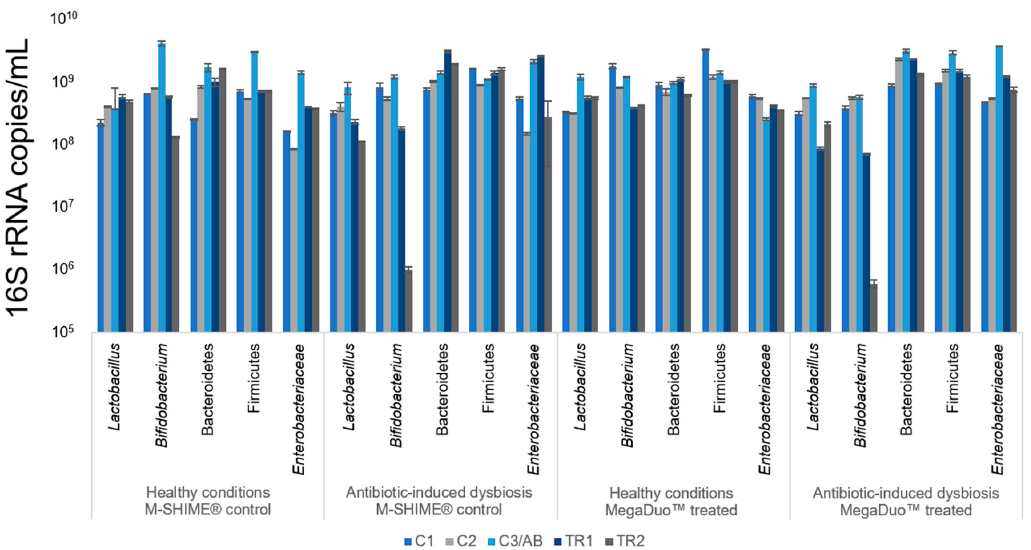
Figure 3. Mucosal microbial community composition as assessed by qPCR. All data are shown as 16S rRNA copies / mL in the mucosal phase of the proximal colon. All samples were analyzed in triplicate. Data are shown as mean ± standard deviation. C1 = control Week 1; C2 = control Week 2; C3/AB = control Week 3 (healthy condition, pre-treatment) / antibiotic (antibiotic-induced dysbiosis condition, pre-treatment); TR1 = treatment Week 1; TR2 = treatment Week 2; M-SHIME ® = mucosal simulator of the human intestinal microbial ecosystem.